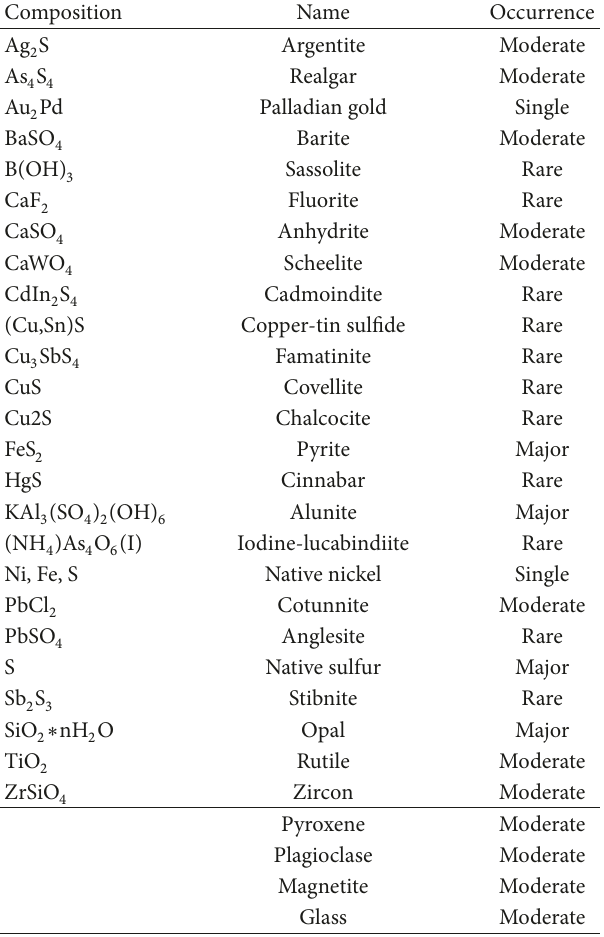
Table 4: Phase list and occurrence frequencies of minerals in fumarolic sulfur from Ebeko.